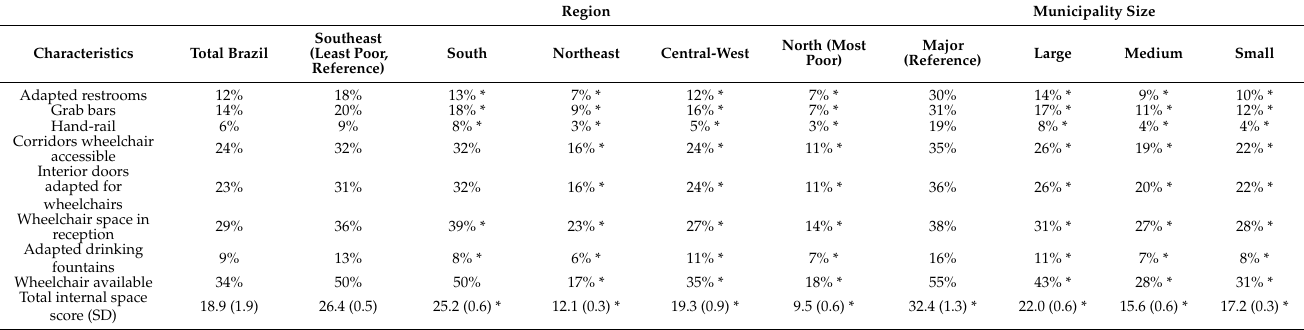
Table 4. Accessibility of internal space of primary health care facilities, by Region of Brazil and Municipality Size. Region MunicipalitySize Characteristics Adaptedrestrooms